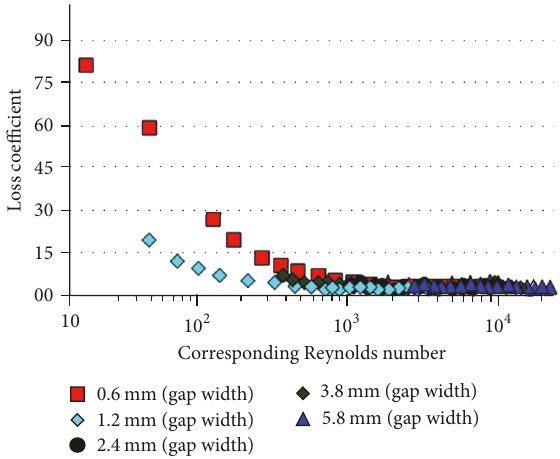
Figure 12: Loss coefficient versus corresponding Reynolds